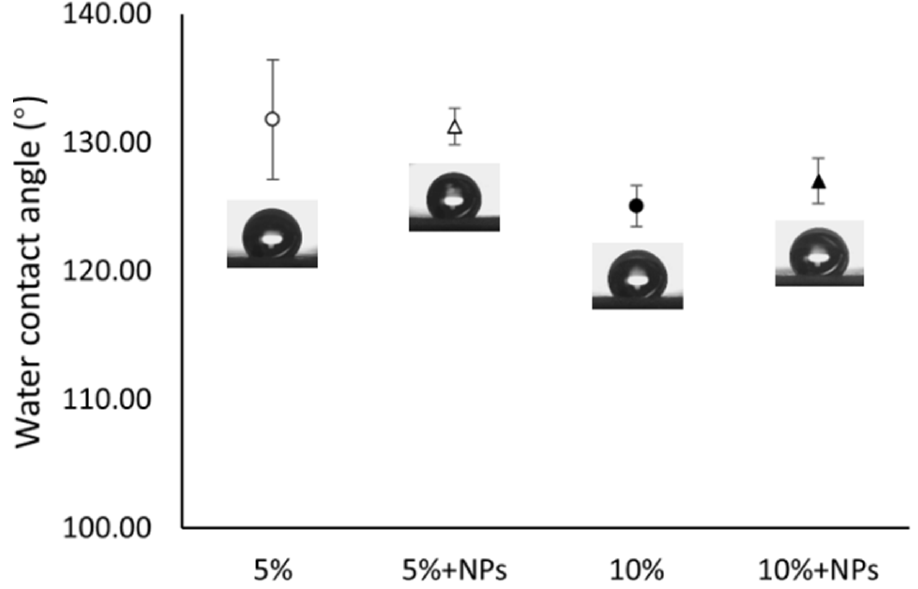
Figure 5. Contact angles of water droplets ( n = 3) on membranes made using 5% and 10% PCL solution with or without NPs. The inserted figures under the error bars are the typical images of the drops on the corresponding nanofiber membranes.